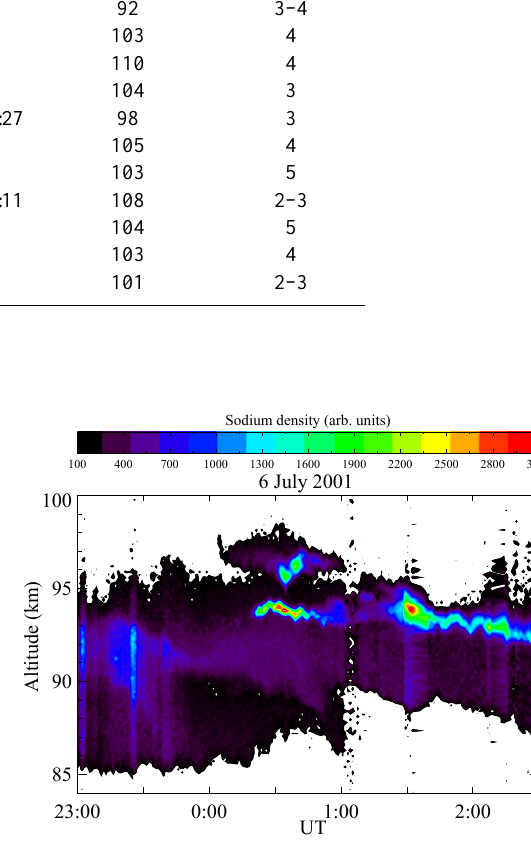
Fig. 9. The Na number density enhancement observed on 6 July 2001. The enhancement at 97km altitude at the topside of the sodium layer is similar to SSLs we observe above ALOMAR dur- ing winter. It did not disappear into an increased background layer and the strongest enhancement was only present for about